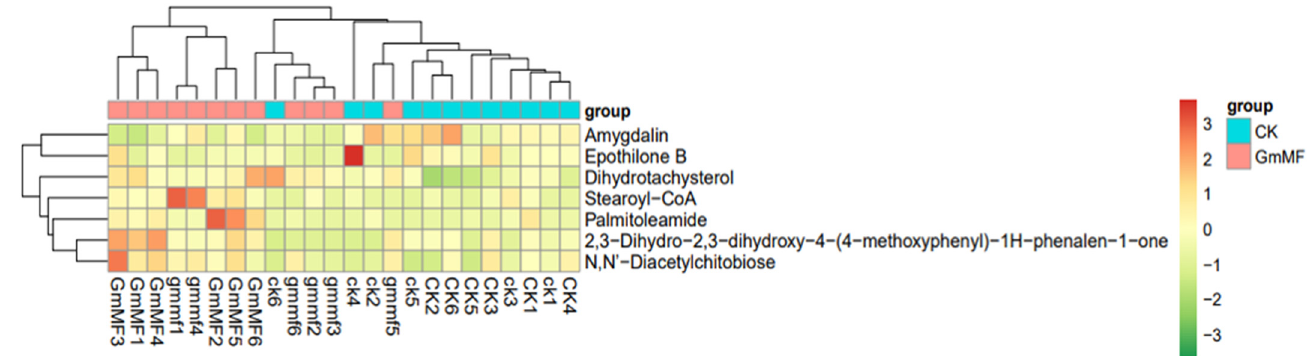
(Table S5). The Amygdalin was related to the Cyanoamino acid metabolism in Gm and Gm + MF inoculated plants (Table S5).